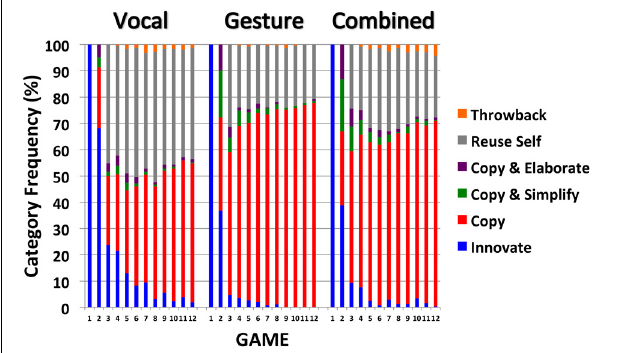
FIGURE 4 | Mean frequency, expressed as percentage scores, of Innovate, Copy, Copy, and Simplify, Copy and Elaborate, Reuse Self and Throwback signs across Games 2–12 for participants in the Vocal, Gesture and Combined modalities. Error bars indicate the standard errors of the means.